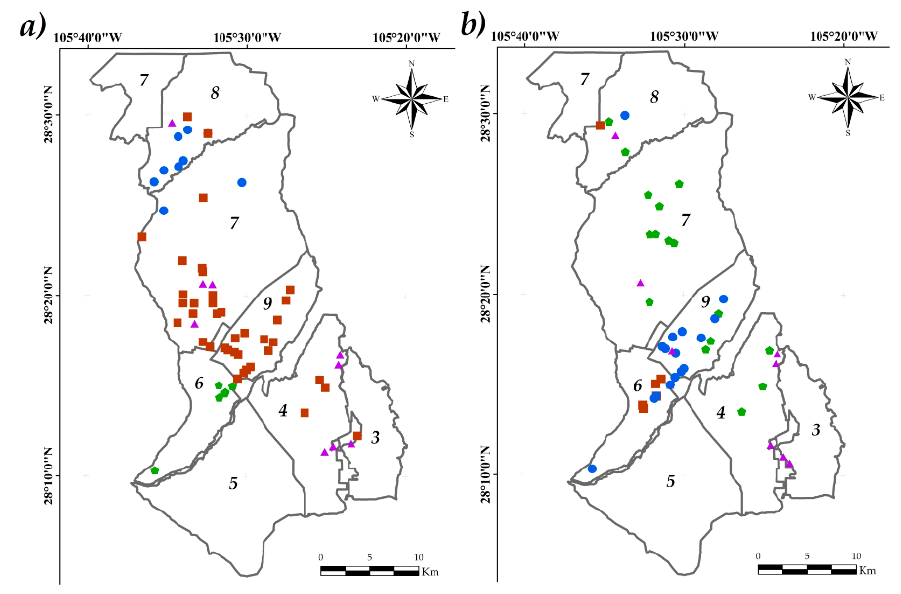
Figure 5. Spatial distribution of the groups in the IDDR005. S1 ( a ), S2 ( b ). Group 1 ( ● ), Group 2 ( ■ ), Group 3 ( ), Group 4 ( ▲ ), bold numbers denote the module number.